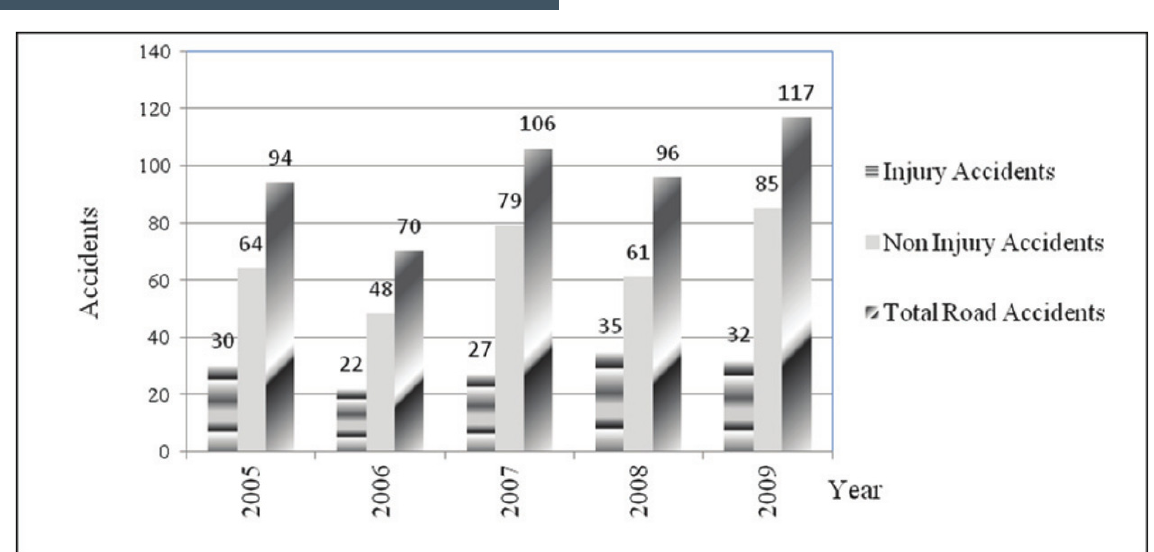
Figure 1. Bar chart of accident data for Akure from year 2005 to year